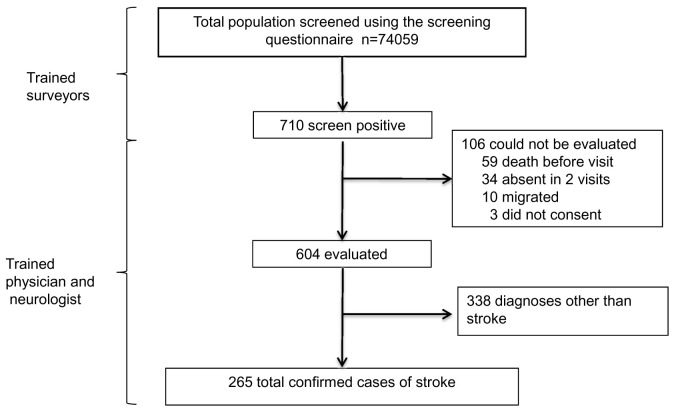
Flow diagram of the study scheme.